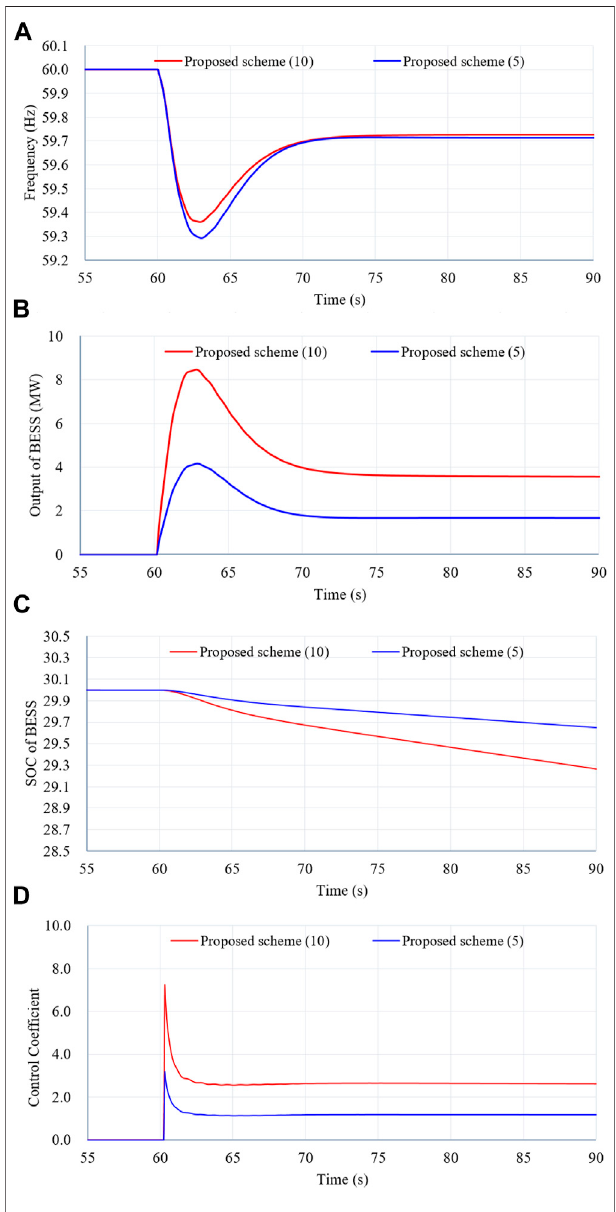
FIGURE 12 | Results for Case 4. (A) System frequency. (B) Output power of the BESS. (C) SOC of the BESS. (D) Control coef fi cient.